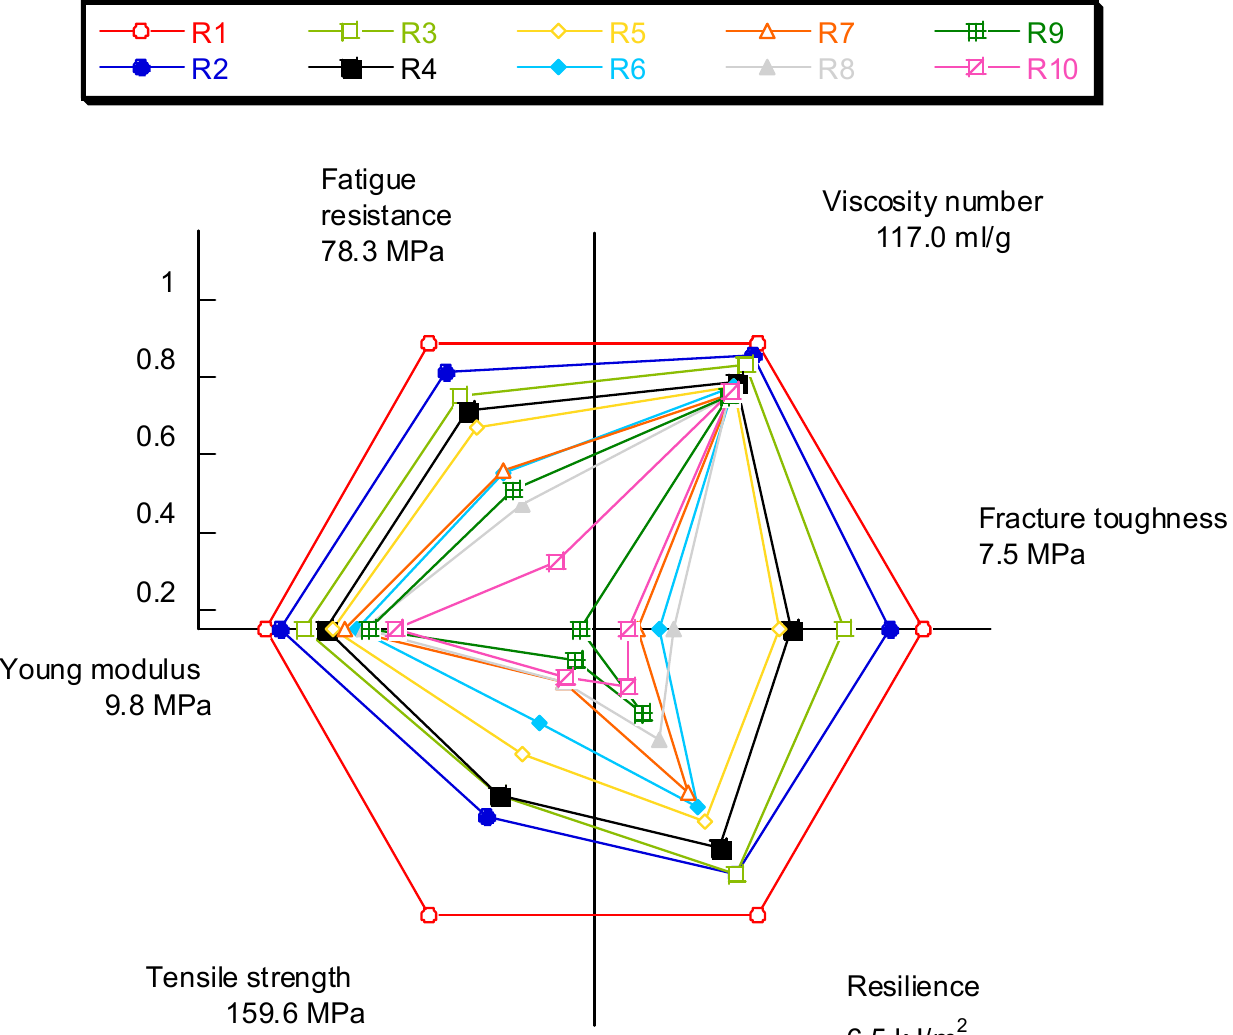
Figure 17. Radar graph showing the decrease in properties of the short glass fiber-reinforced polyamide as a function of the number of recyclings.